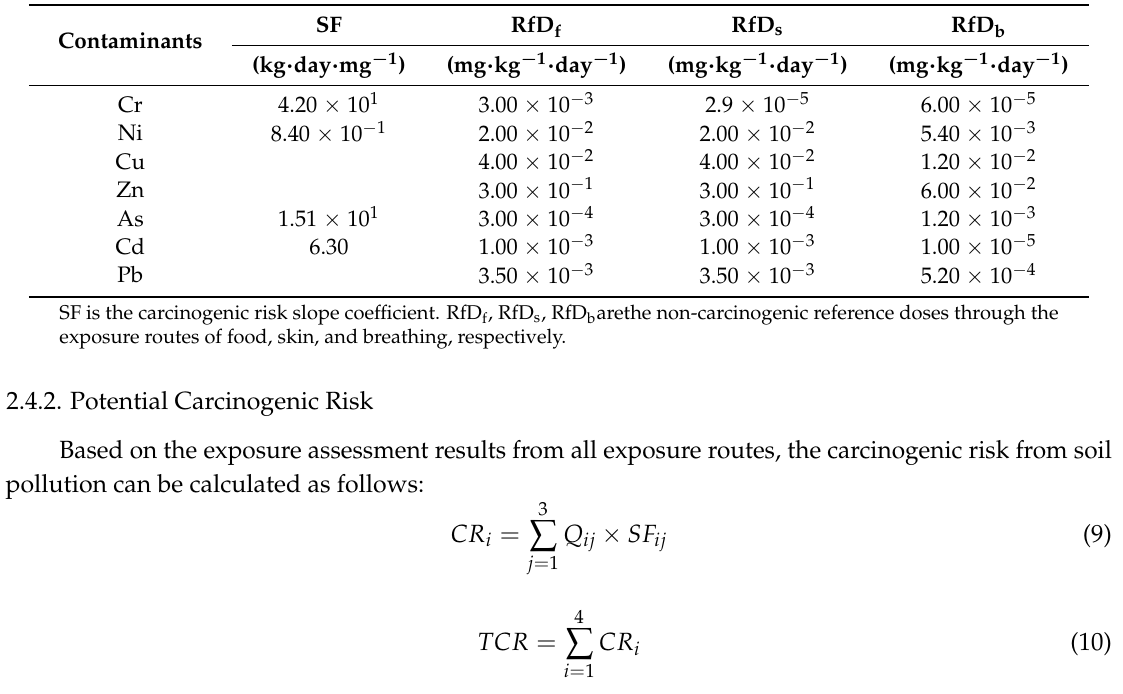
Table 3. Reference dose and slope coefficient of contaminants through different exposure routes (IRIS, US